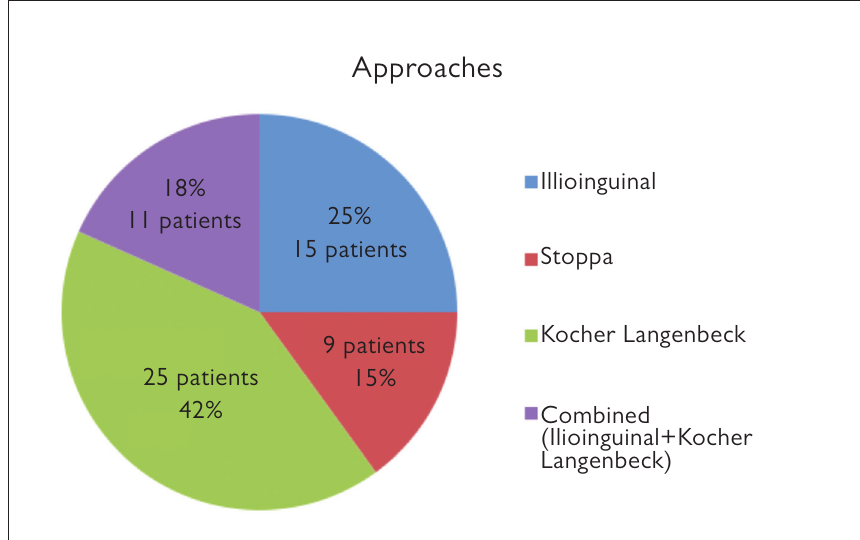
Figure 1. Distribution of surgical approaches in 60